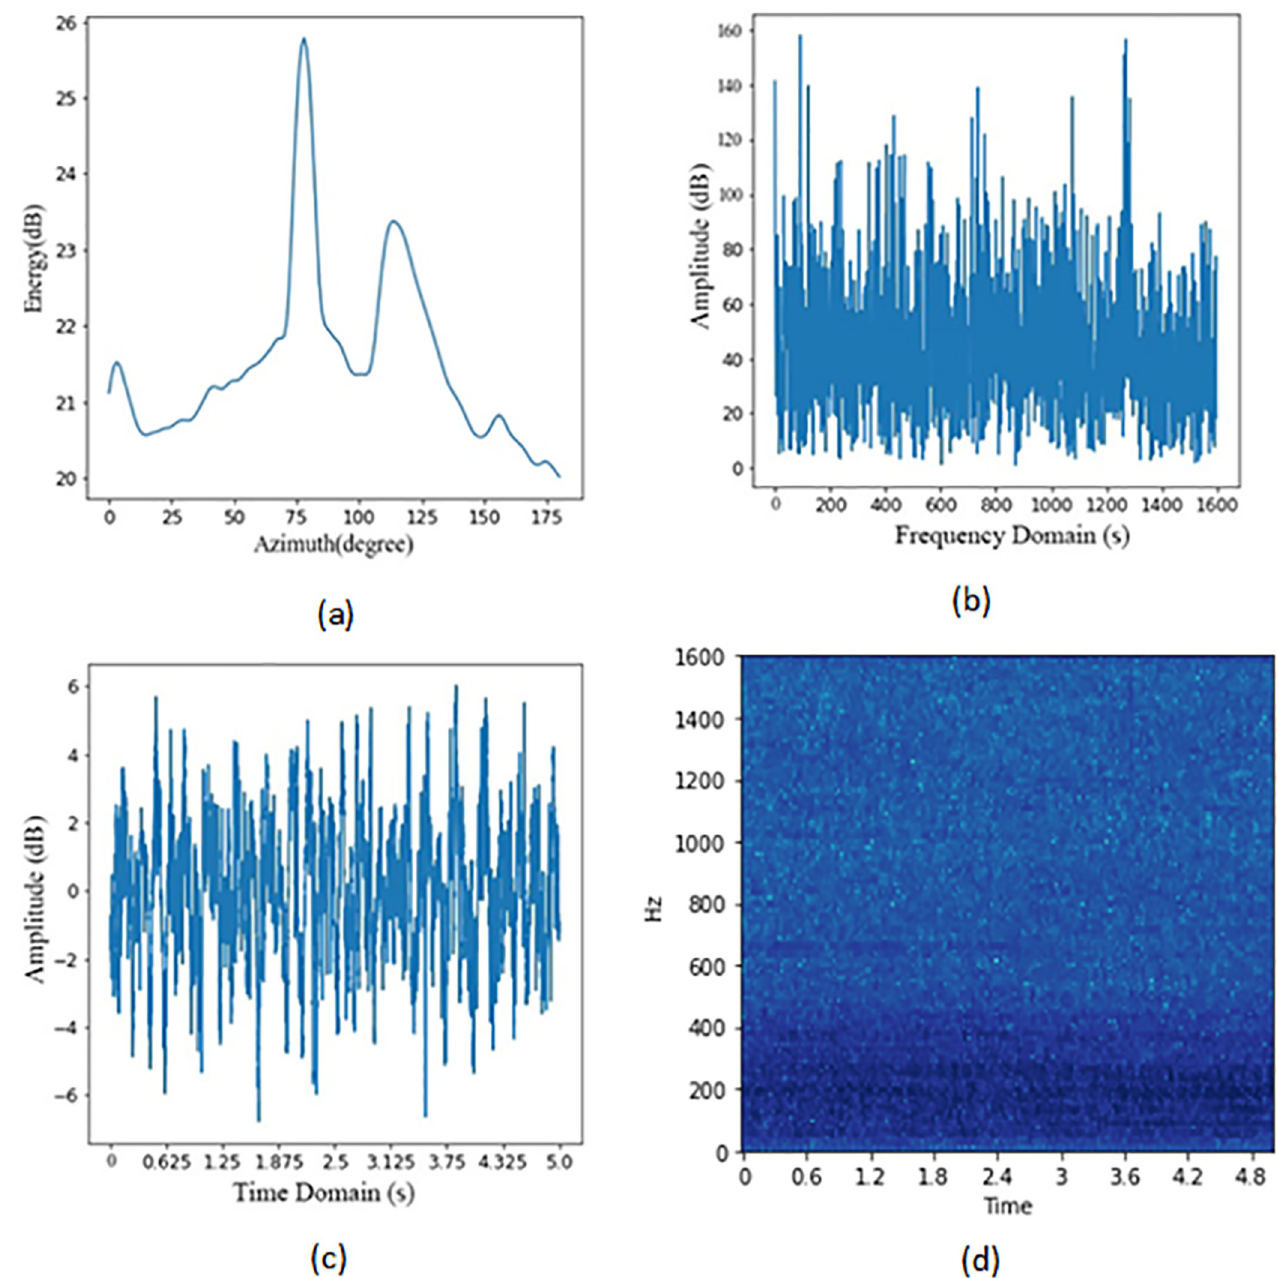
Fig 2. Target multi-beam LOFAR spectrogram obtained in a single collection. (a) Spectrogram of spatial energy distribution obtained by beamforming, (b) The frequency domain data waveform after target bearing weighting, (c) Time-domain data waveform after target azimuth weighting, (d) Multi-beam LOFAR spectrogram of the